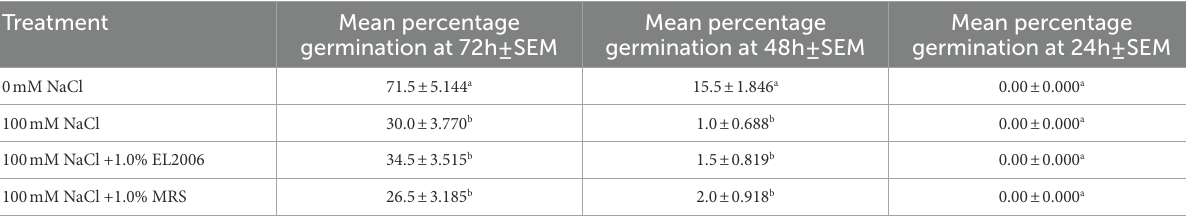
TABLE 4 Effect of treatments on mean percentage germination of corn at 72, 48 and 24 h, respectively. Treatment